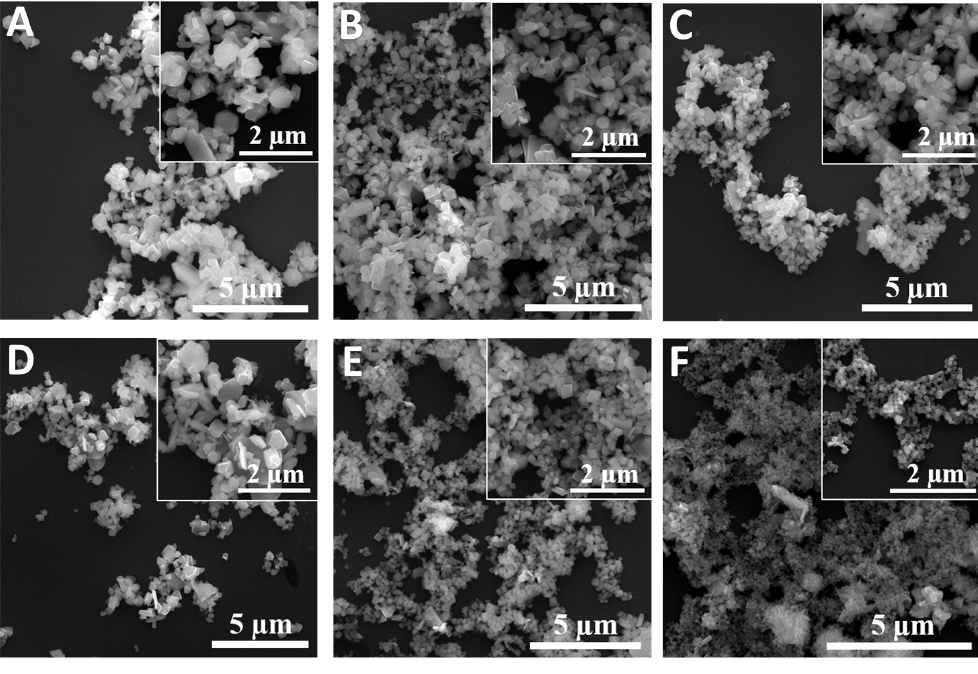
Figure 1. Representative SEM images of Cu x Fe y O z NPs designated by CH 2 O addition in synthesis. ( A ) S200; ( B ) S250; ( C ) S300; ( D ) S350; ( E ) S400; and ( F ) S500.